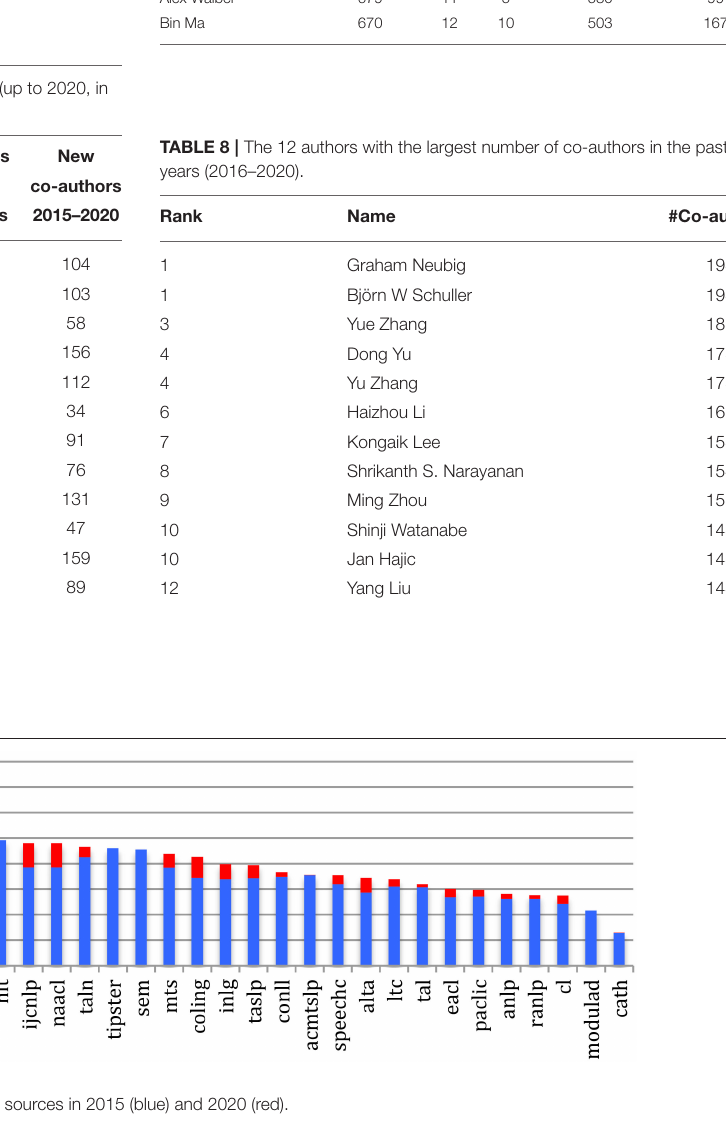
Frontiers in Research Metrics and Analytics |